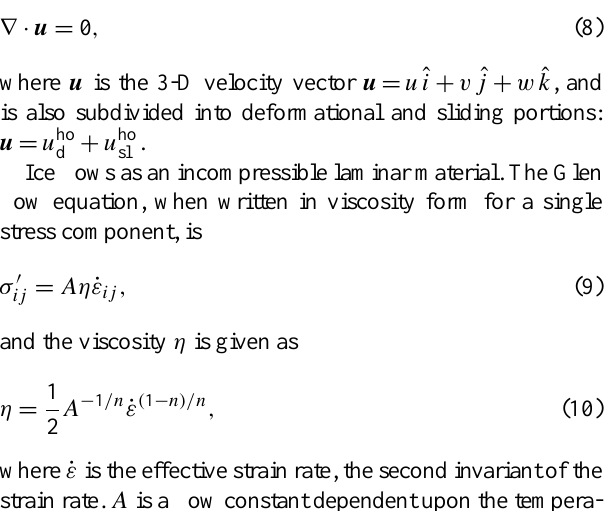
Figure 2. Graphical representation of the mesh used within the HO nested model. The width and depth correspond to those of the black box in Fig. 1. The height corresponds to the ice thickness, and the bottom edge is at the elevation of the topography. The mesh is ex- plained further in Sect.